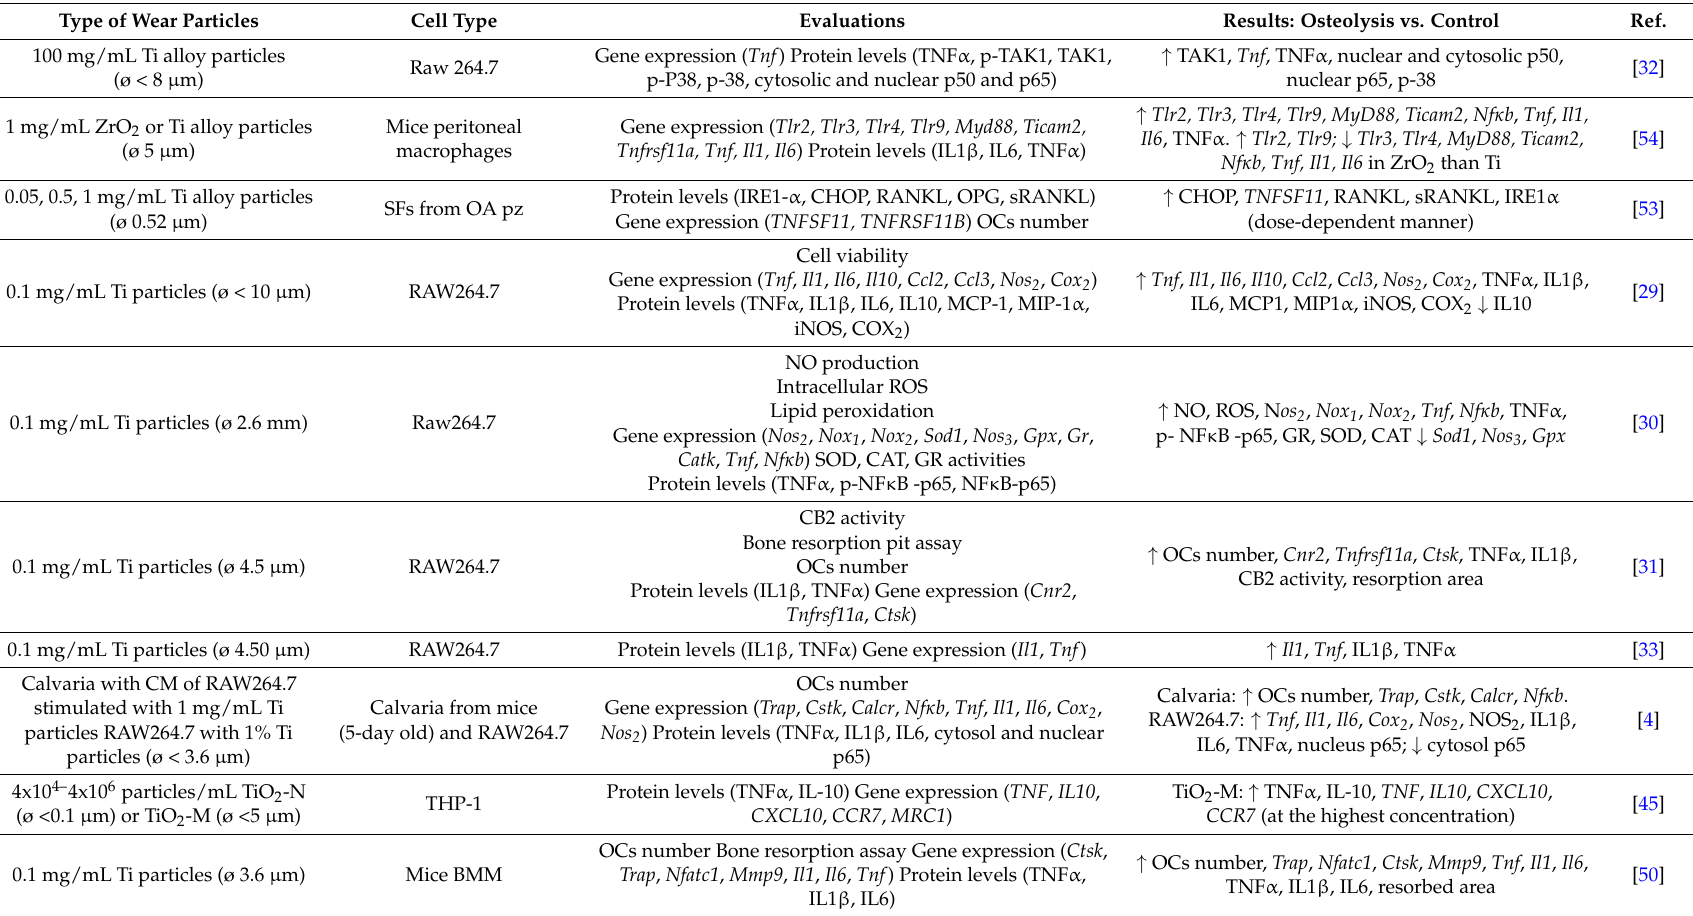
Table 1. In vitro